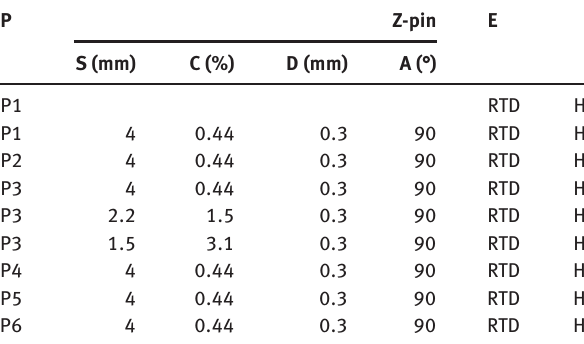
Table 2: Z-pin programming of the